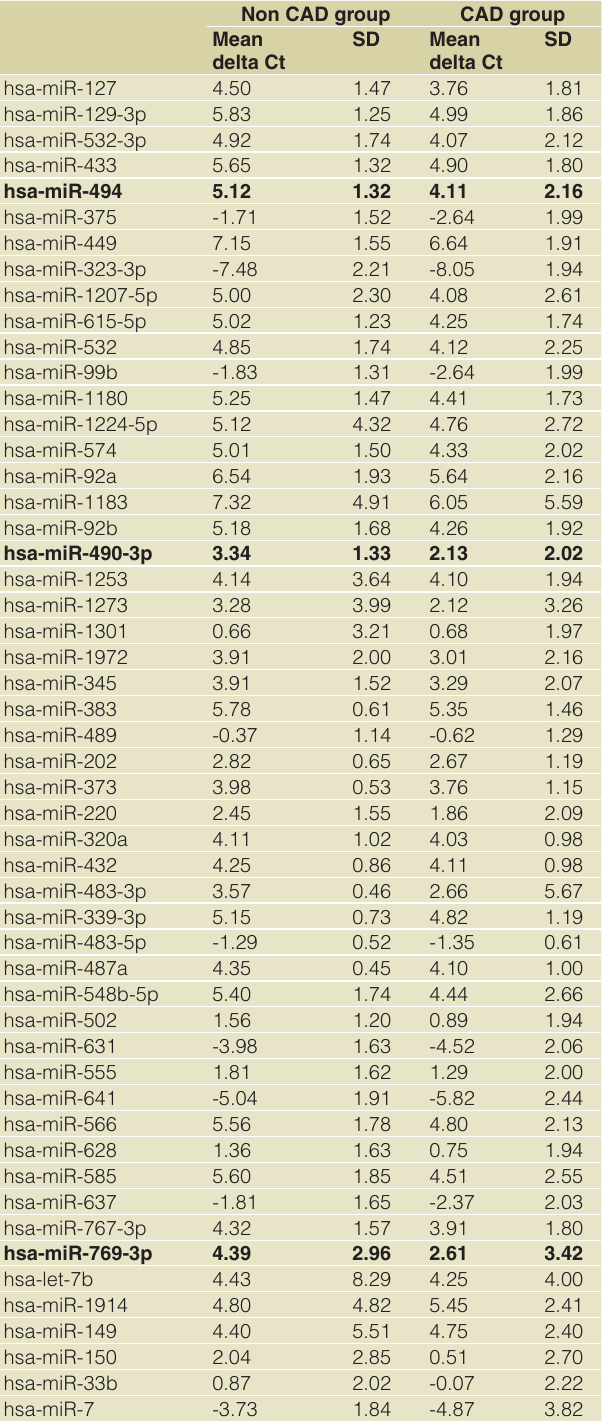
Table 3. Expression of plasma miRNAs in patients with ≥ 70% CAD as compared to patients with <70% CAD or normal arteries. Data is expressed as the mean delta Ct (Normalized to the RNU1A) and standard deviation. A lower number indicates increased miRNA expression. Bold valuesones are associated with CAD. More explanation in Table 5.